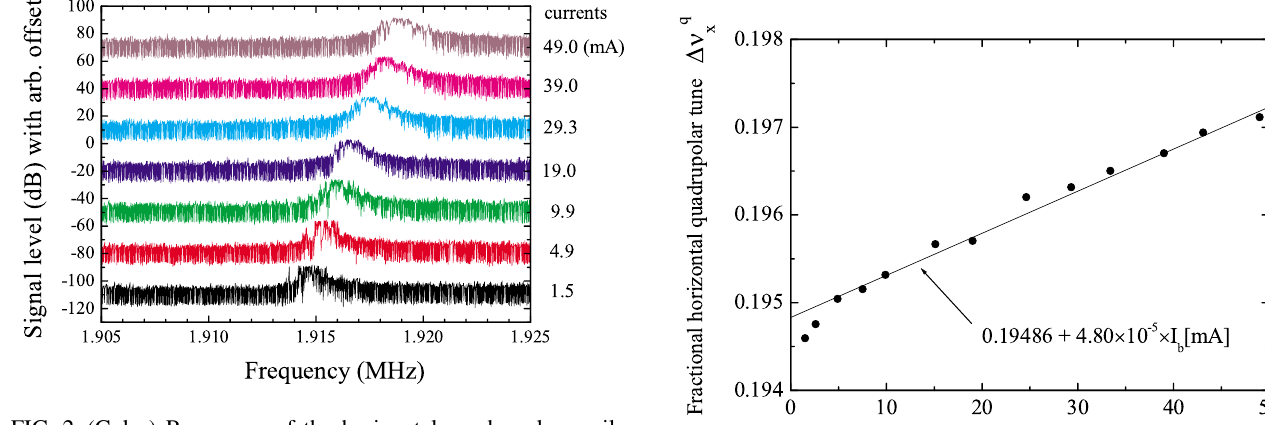
FIG. 2. (Color) Responses of the horizontal quadrupolar oscil- lation measured under different bunch currents. Abscissa, exci- tation frequency; ordinate, intensity of the photomultiplier signal. Note that the neighboring traces were separated by addi- tional offsets (30 dB between neighboring traces). The excitation frequency was swept upward.